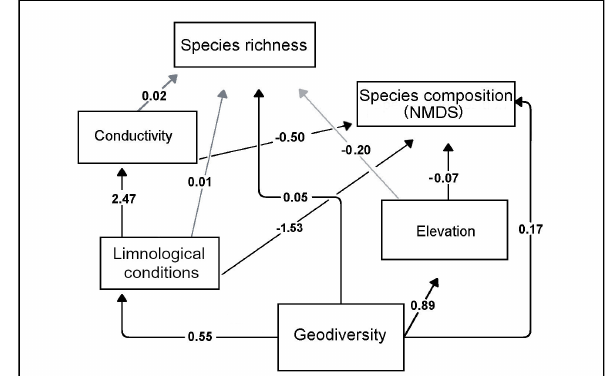
Figure 6. Structural equation modeling of the influence of geodiver- sity and limnological conditions with freshwater ostracode species composition and distribution. Metrics of global fit of the optimal model CFI −− 0 . 941, RMSEA −− 0 . 01, and SRMR −− 0 . 035. Ar- rows indicate the direction of influence. Black arrows are paths sta- tistically significant at p